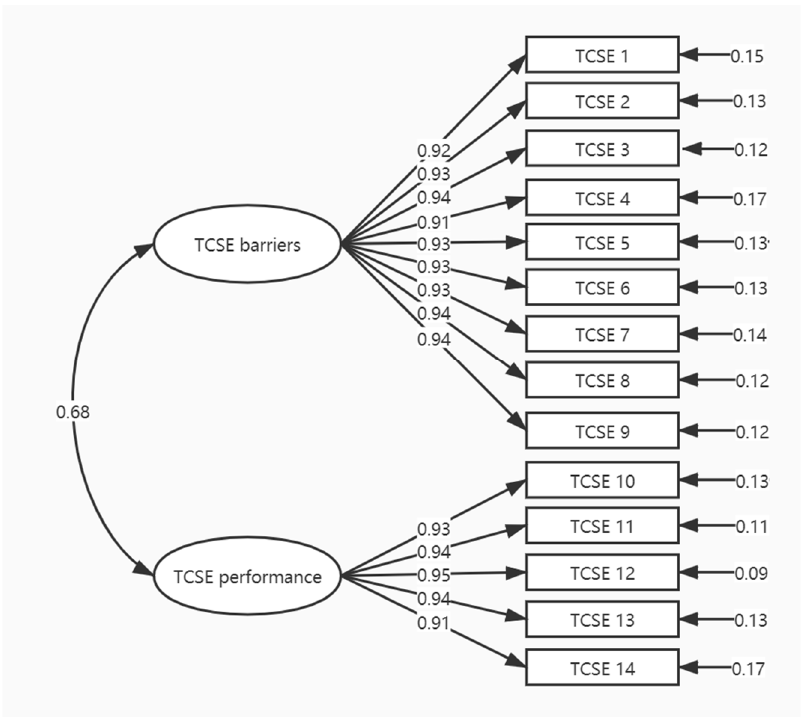
Figure 2. Confirmatory factor analysis model for the TCSE scale (Mandarin Chinese version). Table 3. Item analysis for the TCSE scale (Mandarin Chinese